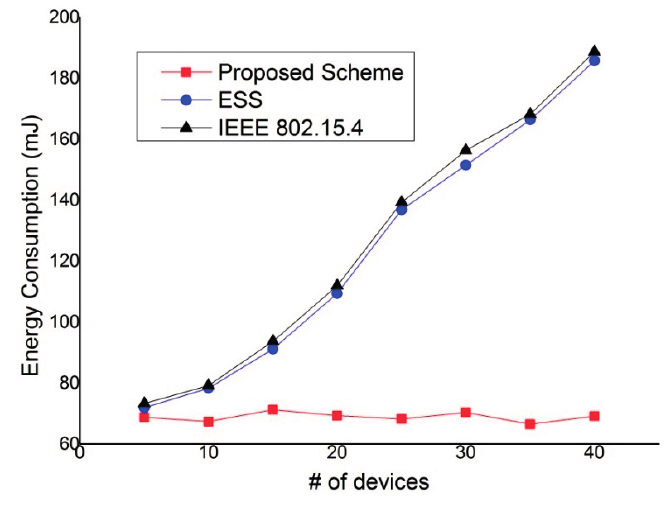
Figure 22. The energy consumption of device versus the number of devices in the